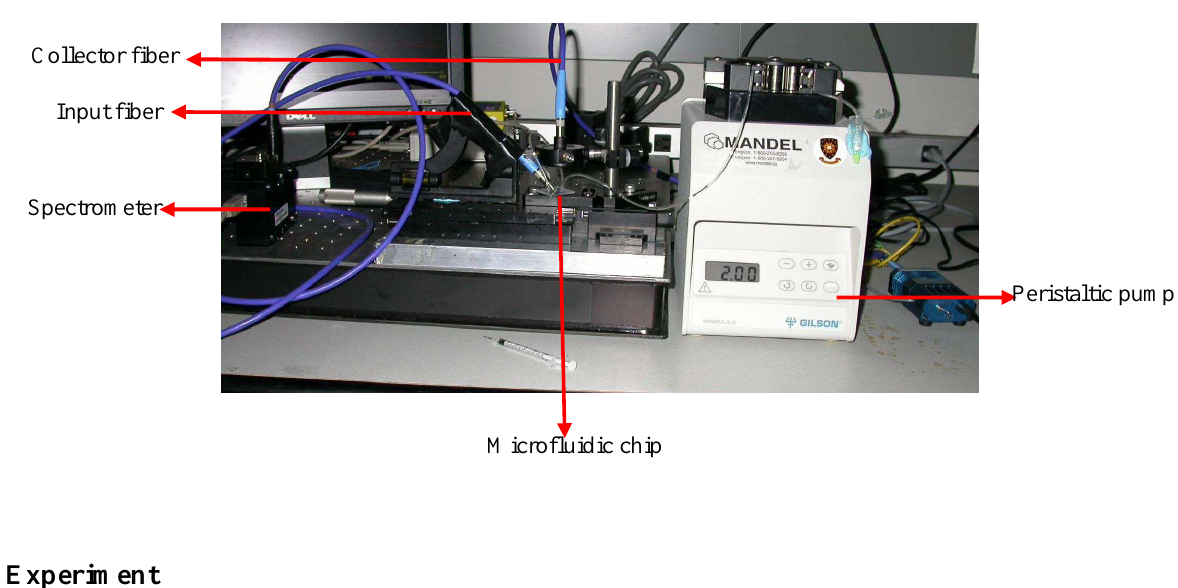
Figure 8: Bio-optical Fluorescence detection setup at the Optical Microsystems